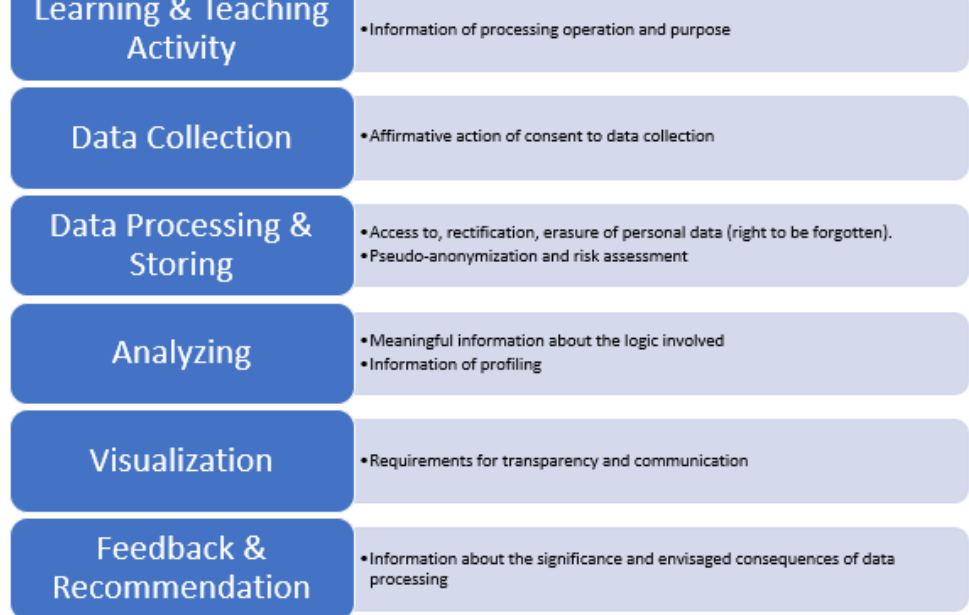
Figure 8. Correspondence among ISO/IEC TR 20748-1:2016 phases and their corresponding privacy requirements [16]. Table 1. Correlation among GDPR rights implementations and the affected LA phases in our CyberScratch project. GDPR